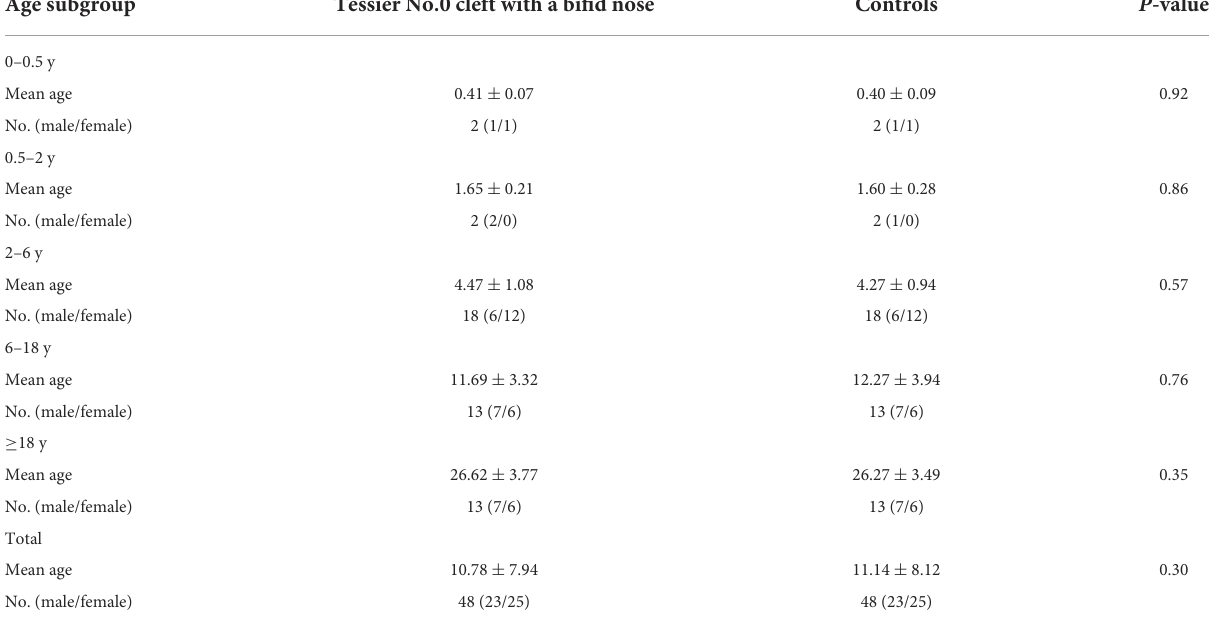
TABLE 1 Demographic information of Tessier No.0 cleft with a bifid nose and